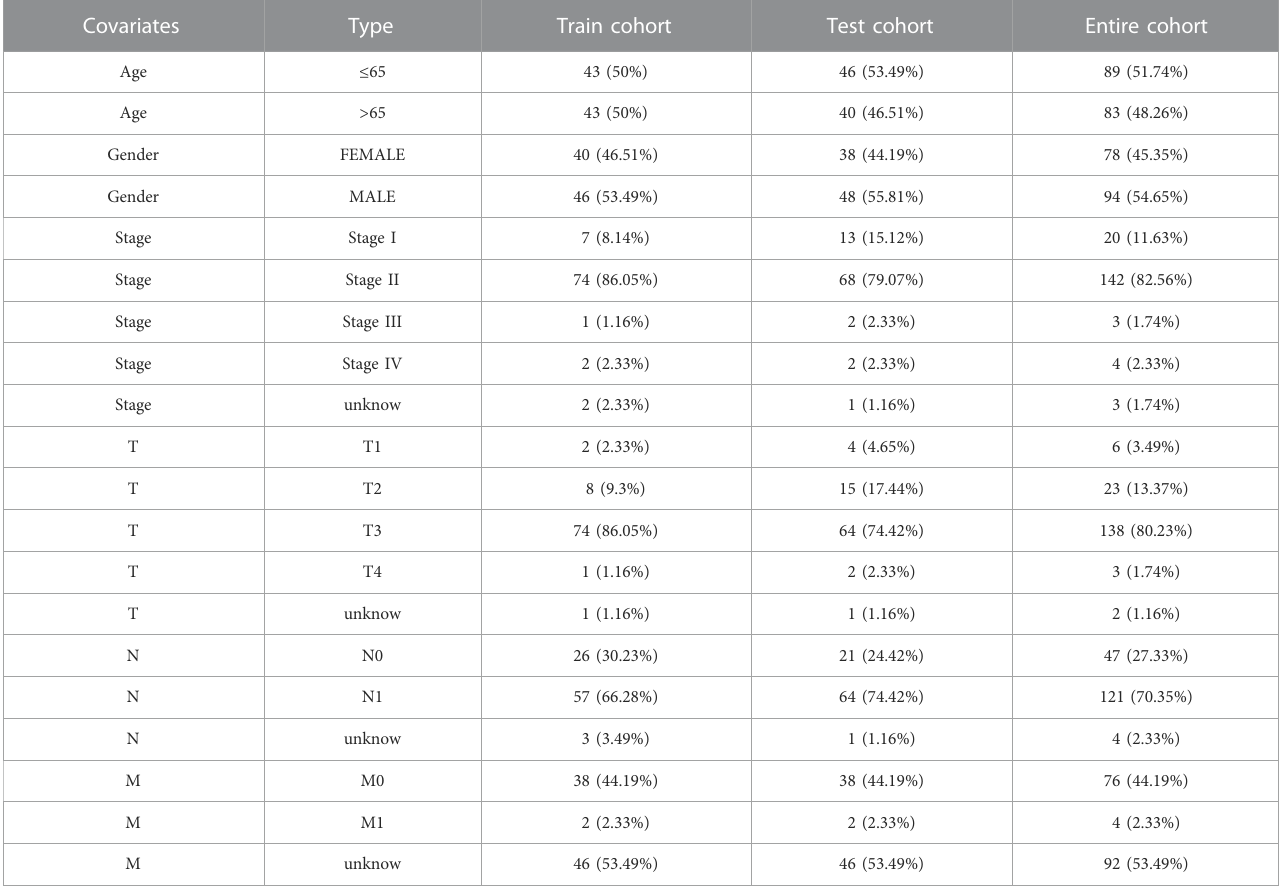
TABLE 1 The distribution of clinical features in three cohorts.